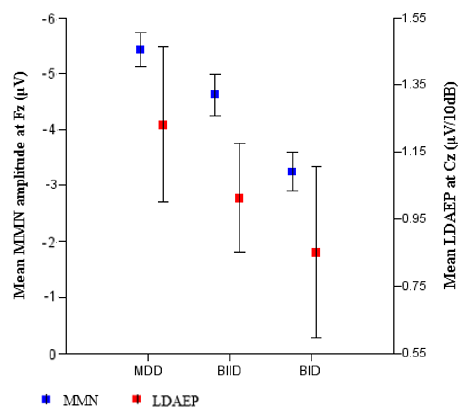
Figure 3. Mean MMN amplitude (Fz) ( p = 0.026) and LDAEP (Cz) ( p = 0.52) among patients with major depressive disorder, bipolar II disorder, and bipolar I disorder classified according to clinical diagnosis based on the DSM-5 (Diagnostic and Statistical Manual of Mental Disorders).